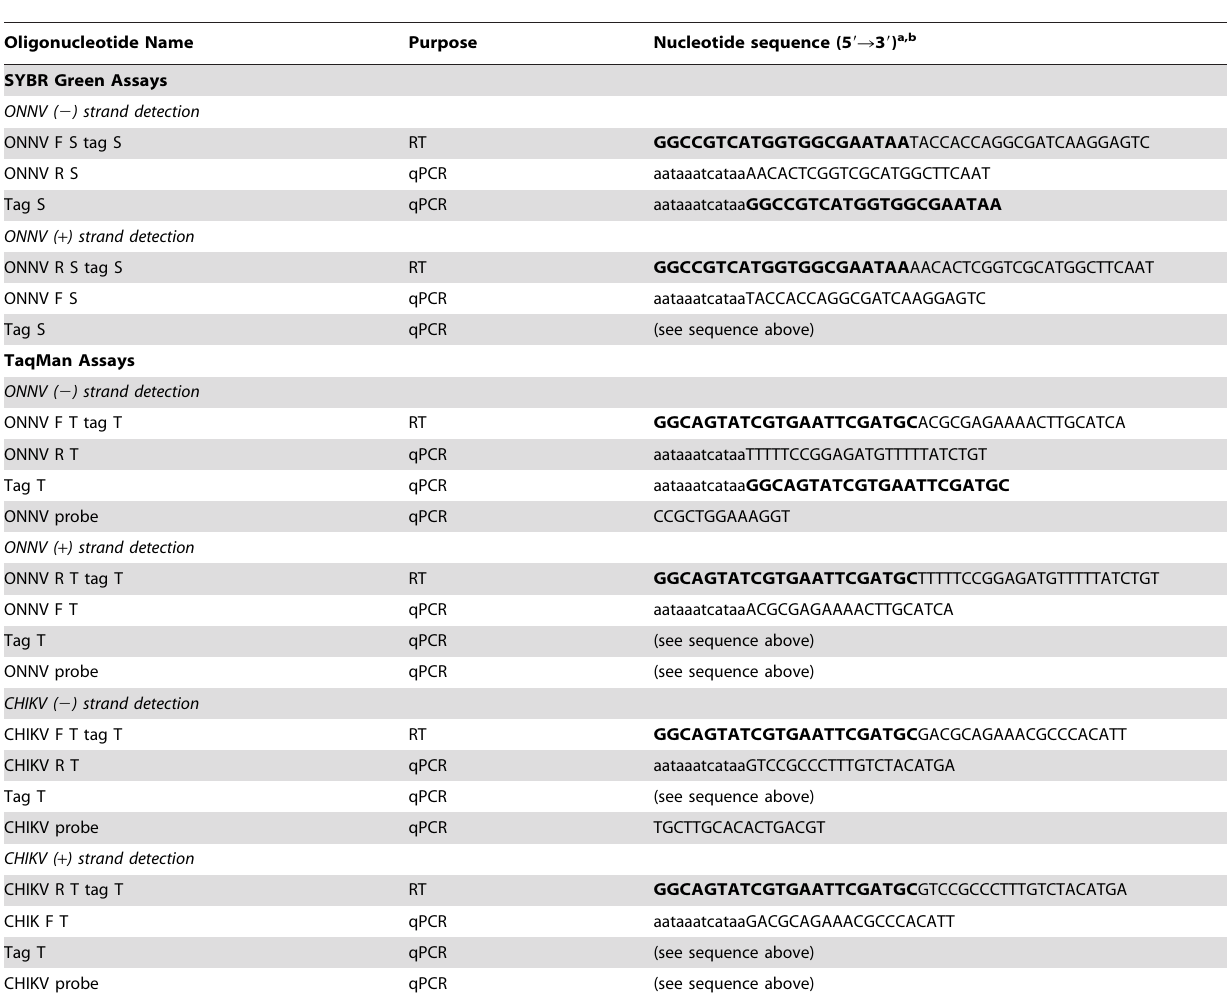
Table 1. Sequence of primers and probes used for reverse transcription (RT) and quantitative PCR